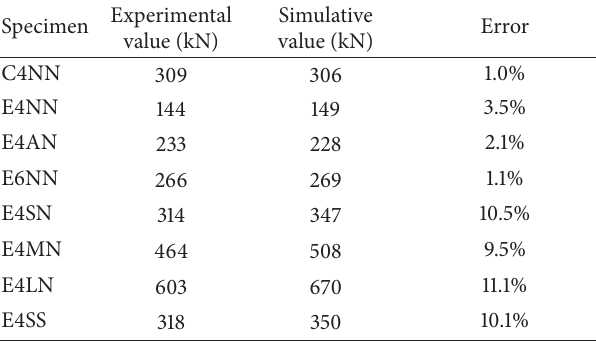
Table 4: Comparison of the experimental and numerical field capa-